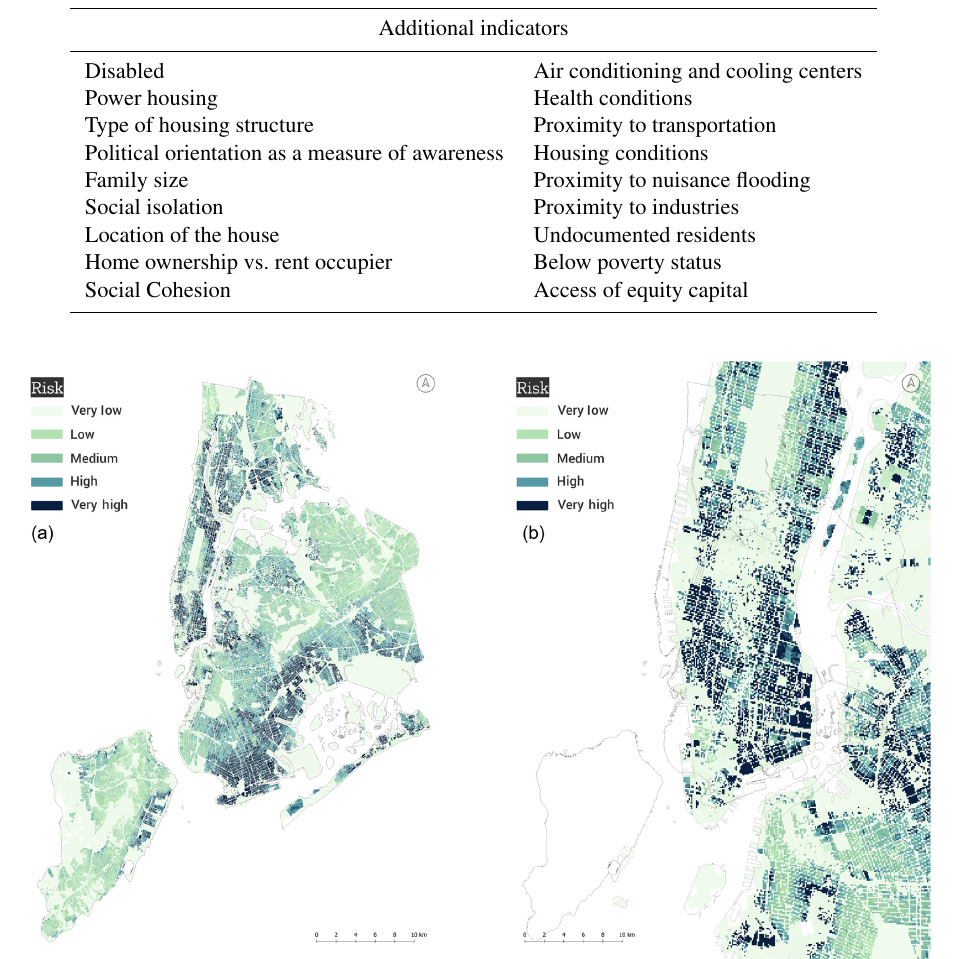
Figure 6. Final multi-hazard risk map and detail of the high spatial resolution risk map for Lower Manhattan and parts of Brooklyn. (a) Multi- hazard risk map. (b) Detail of the multi-hazard risk